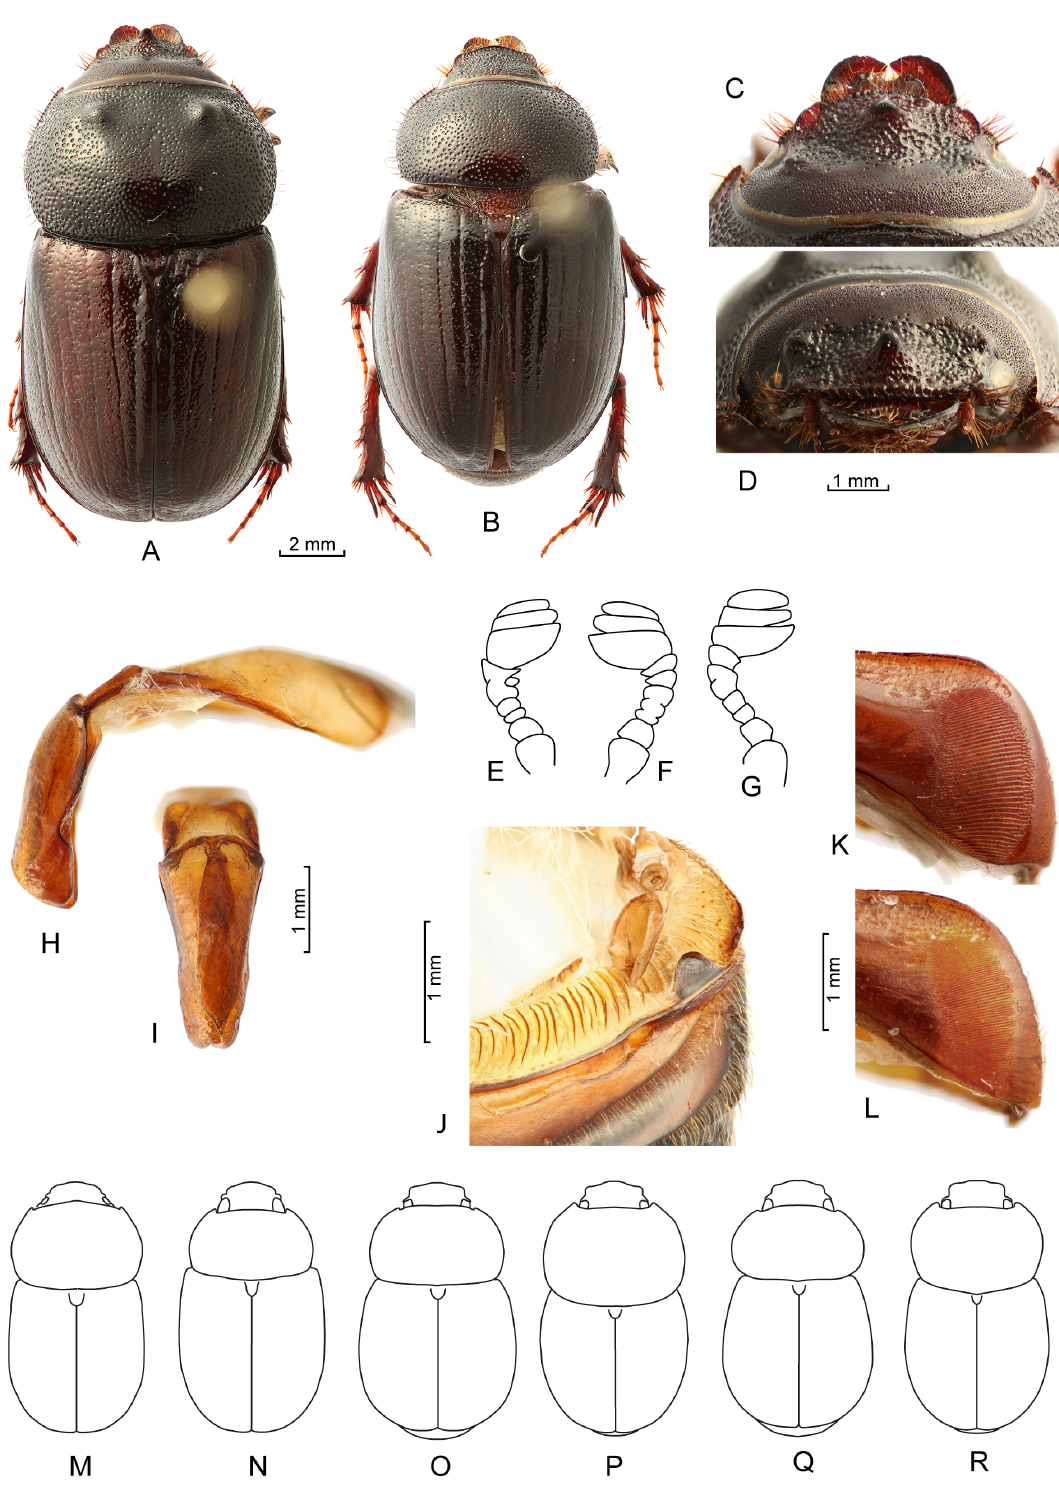
Fig. 1. — A–M . Orphnus giganteus Paulian, 1948. A–B . Habitus. C–D . Head in dorsal and apical view. E–G . Antennae. H . Aedeagus in lateral view. I . Parameres in dorsal view. J . Abdomen in dorsal